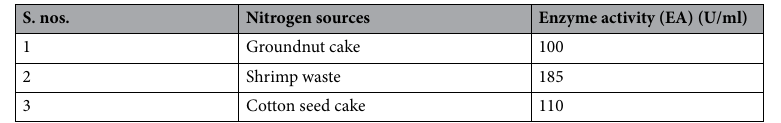
Table 2. Various nitrogen sources as substrate used as a complex media and it enzyme activity. Relative uncertainty for the enzyme activity is u r (EA) = 0.02 U/ml.